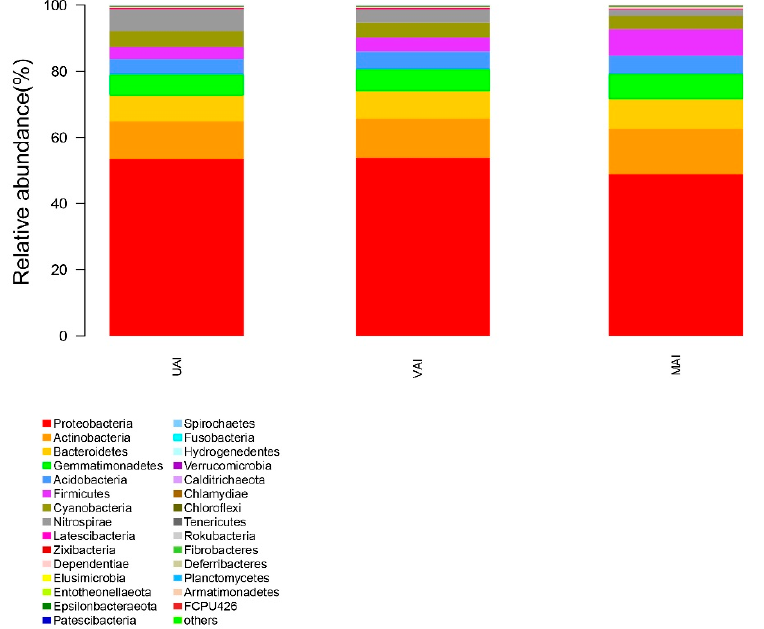
Figure 10. Bar chart of community structure in drip irrigation system (microbial communities with the top 30 microorganisms in the sample).